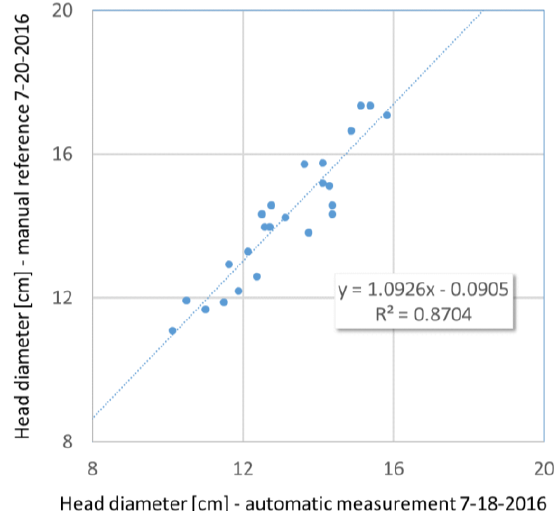
Figure 11: Relationship of cauliflower head size manually measured vs. automatically measured, N = 22 lines (184